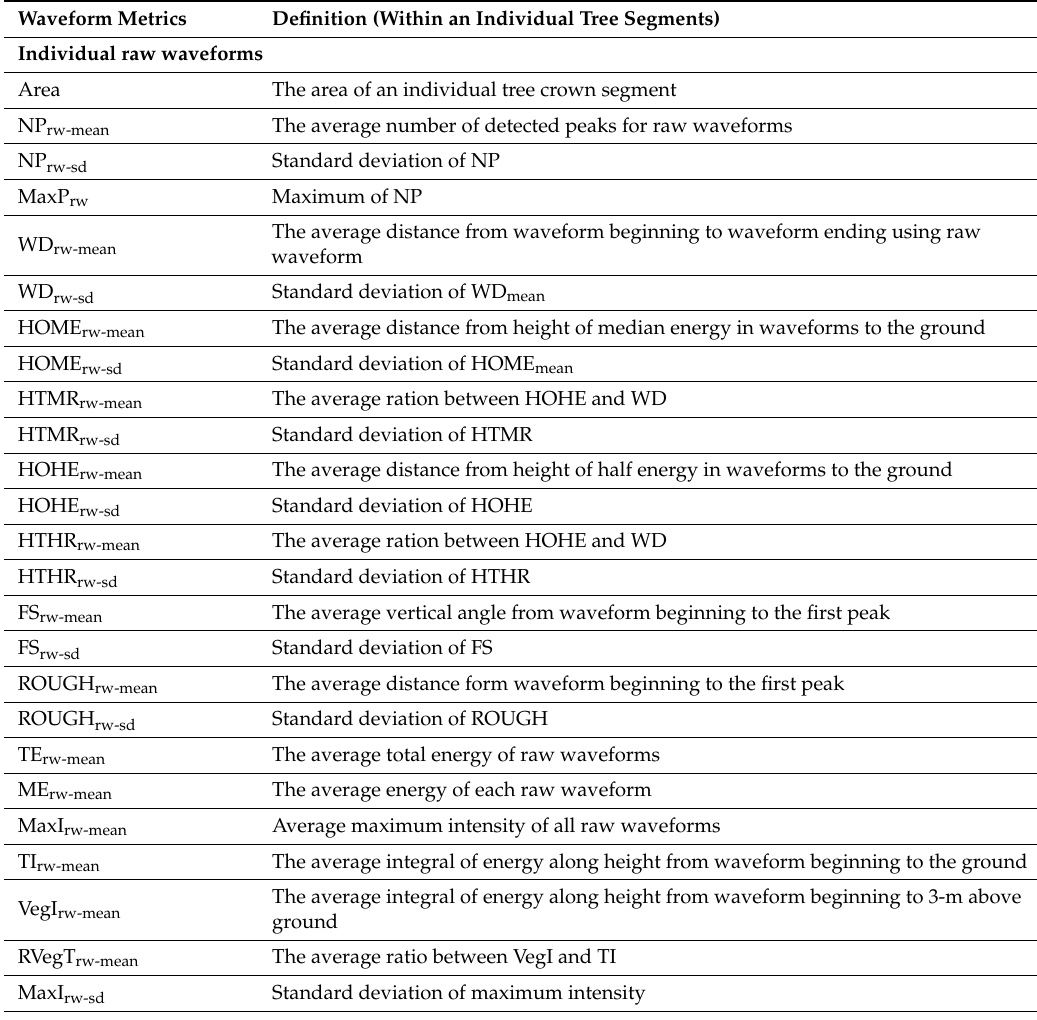
Table A1. Summary of FW metrics from FW LiDAR